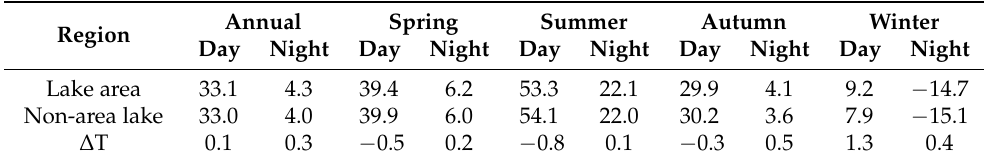
Table 1. Comparison of average LST of the lake and non-lake areas (unit: °C). Region Lake